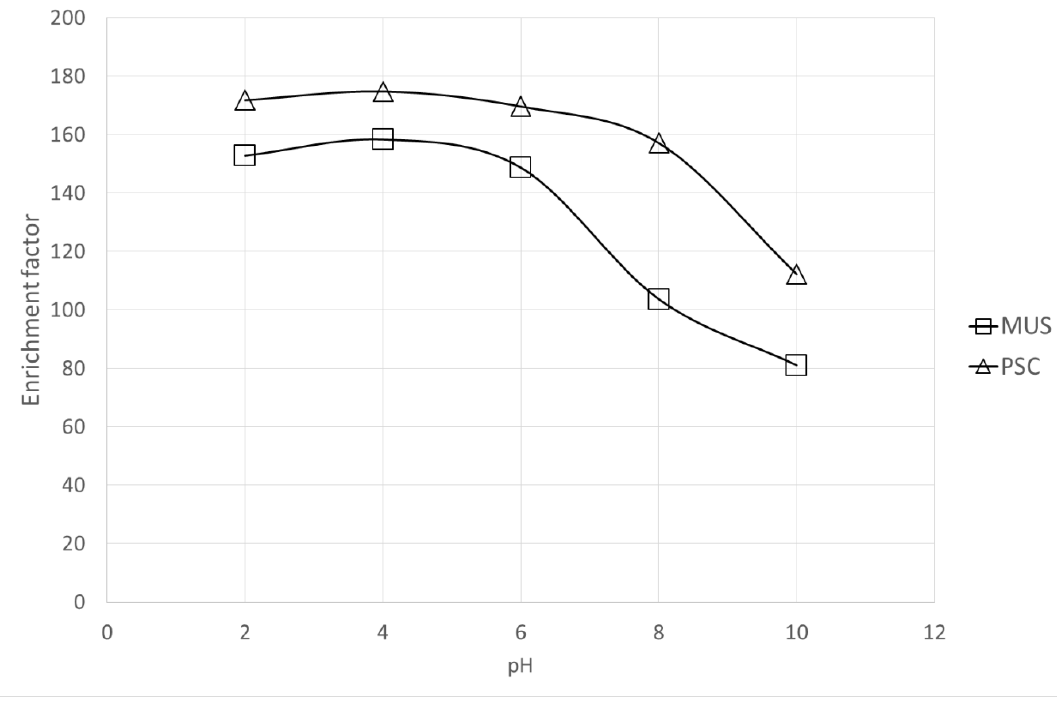
Figure 2. Preconcentration of MUS and PSC versus pH of the donor phase. Sample concentration: 25 mg L − 1 , at pH in range 2 – 8; CE conditions: BGE—25 mM phosphate buffer pH 3; Sample volume: 200 µL; Organic phase: octanol; extraction time: 180 s; injection: 0.1 psi, 1s; n = 6, RSD < 4.8%.